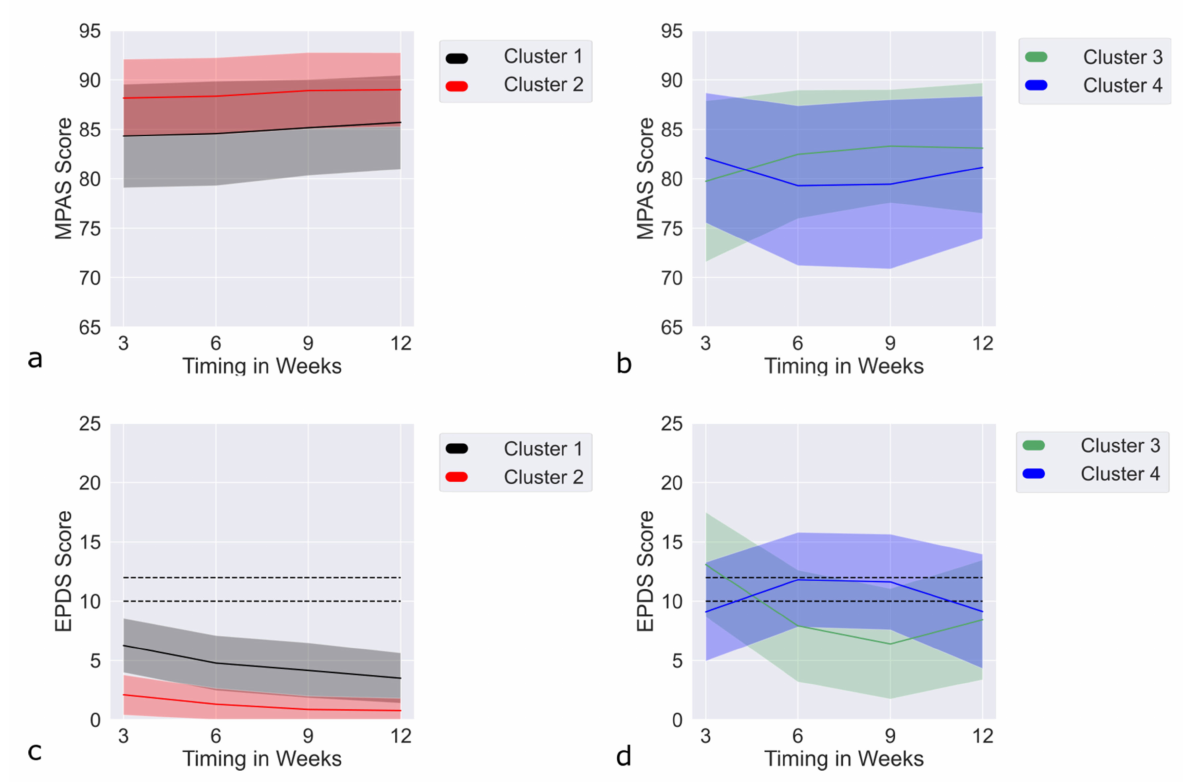
Figure 2. Trajectories of MPAS-EPDS clusters. ( a , b ) MPAS and ( c , d ) EPDS trajectories of multlcmm model with four clusters. Subfigures ( a , c ) represent trajectories of the two baseline clusters, which mostly consist of HC, while ( b , d ) show the U-shaped clusters, with improving and deteriorating EPDS (see text). These clusters demonstrate a strong relationship between MPAS and EPDS. Abbreviations: EPDS, Edinburgh Postnatal Depression Scale; MPAS, Maternal Postnatal Attachment Scale; HC, healthy